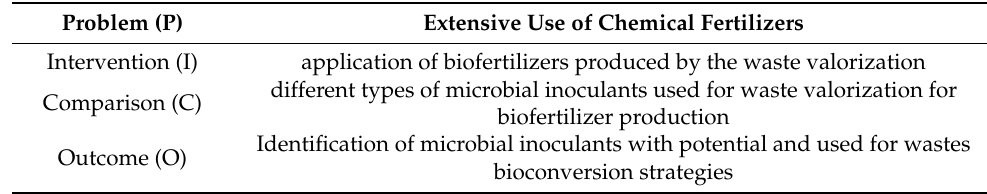
Table 2. PICO framework utilization for the development of the research question.